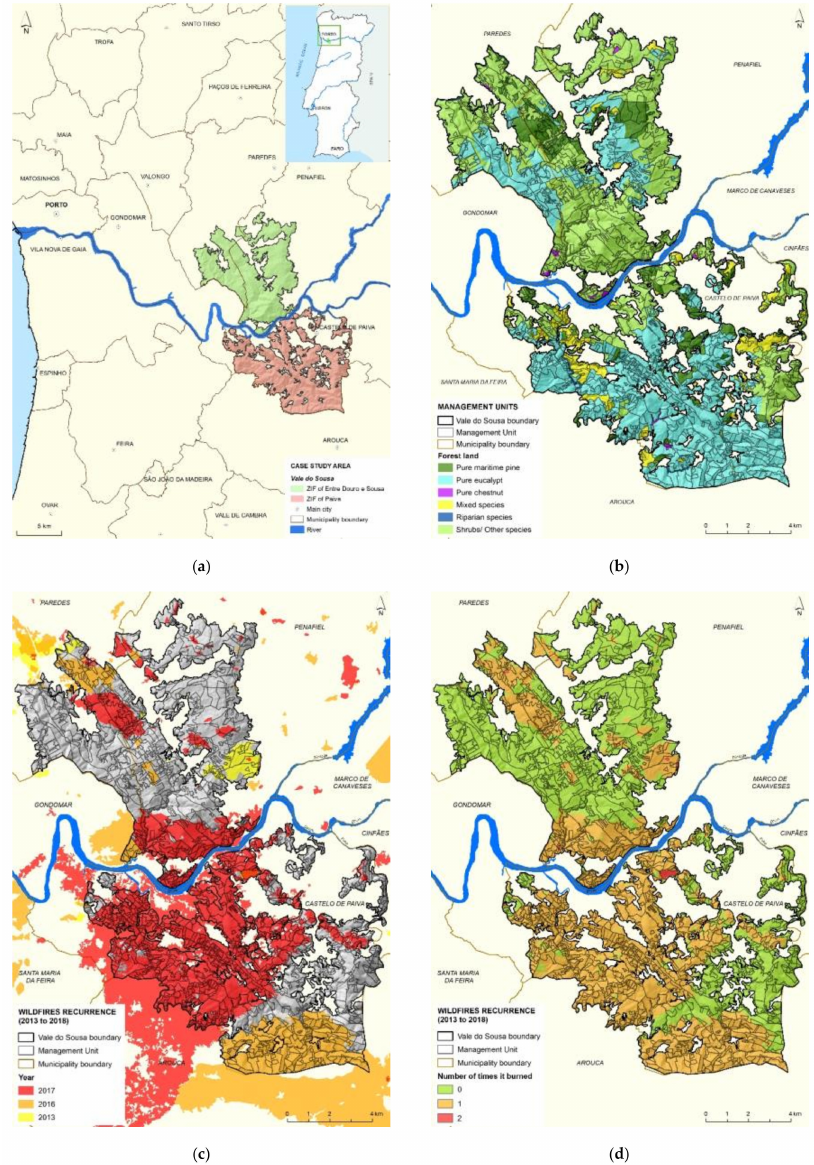
Figure 1. Vale do Sousa case study area: ( a ) location of ZIF of Entre-Douro-e-Sousa and ZIF of Paiva in northwestern Portugal; ( b ) forest land of 1373 management units by cover type; ( c ) burned area over the period of 2013 to 2018; ( d ) wildfires recurrence (2013 to 2018).